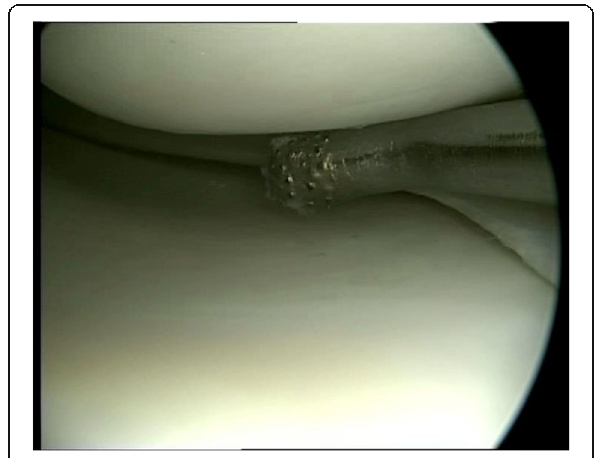
Fig. 3 Preparation of the meniscus lesion. Refreshing of the margins of a meniscus tear by a rasp to induce a slight bleeding as an obligate procedure before meniscus suture to enhance meniscus regeneration (published in (Zellner & Angele,